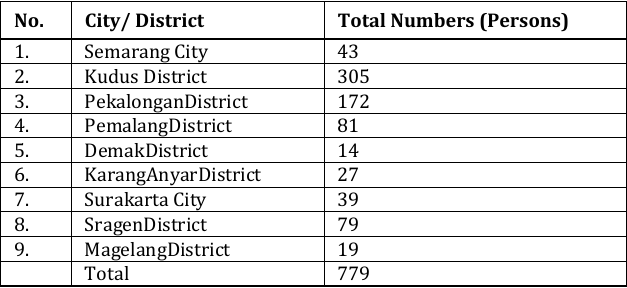
Table 2 : The Data Of Convection Central Supervised By The Industry And Trade Office In Central Java Province No.